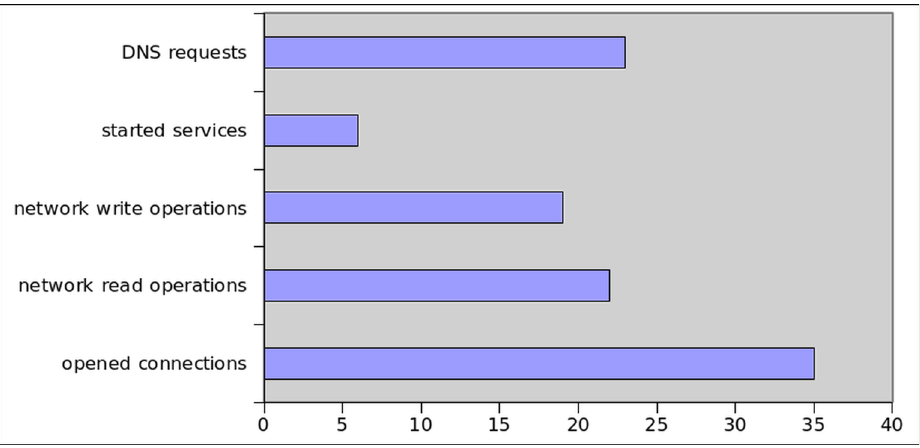
Fig 29. Dynamic Analysis Results of